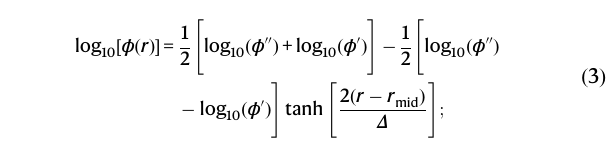
exactly fi ve residues plotted against the distance from the condensate center-of- mass of one of the residues for the wild-type A1-LCD at ω = − 3.38. f Average asphericity of chains plotted against the distance from the condensate center-of- massforthewild-typeA1-LCDat ω = − 3.38.Valuesofasphericitythatarelargerthan 0.4pointtocigar-shapedconformations,atleastonthelocallevel 56 .Thedistinction of chain dimensions across the dilute, dense, and interfacial regions disappears as the critical temperature is approached. In panels a , c , d , e , and f , the translucent green rectangles represent the interfacial region as determined by the logistic fi t and the error bars signify standard errors about the mean across 3 replicates. In panel b , error bars represent standard errors about the mean across 10 replicates. l.u. is lattice units. Source data are provided as a Source Data fi